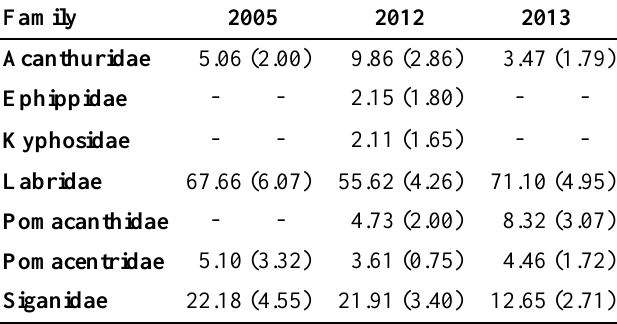
Table A1.2. The taxonomic composition of the herbivorous fish assemblage at each sampling period. Numbers represent the mean percentage of biomass of the herbivorous fish assemblage made up by each family. Numbers in parentheses are standard errors (n = 12 replicate censuses per period [sites pooled]).